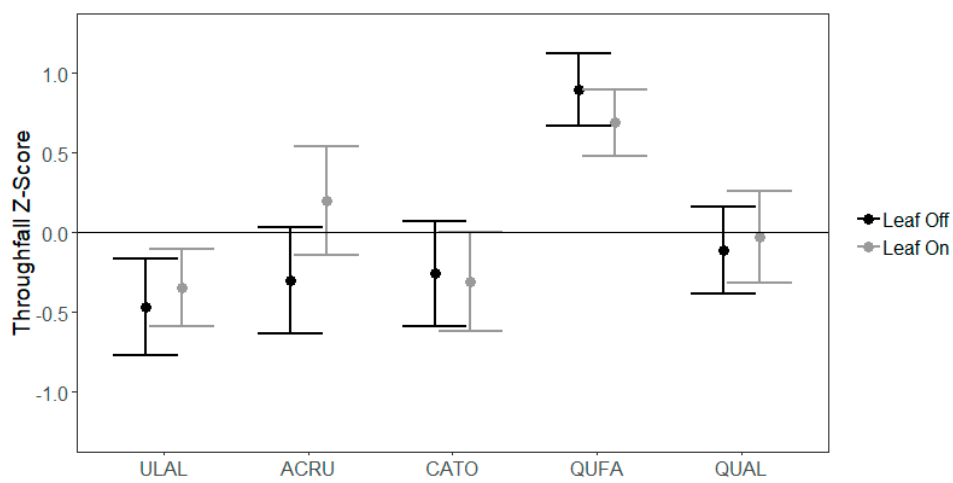
Figure 2. Mean throughfall z-scores (TF z ) with standard error bars for midstory species. Species codes: ACRU = red maple, ULAL = winged elm, CATO = mockernut hickory, QUFA = southern red oak, QUAL = white oak.